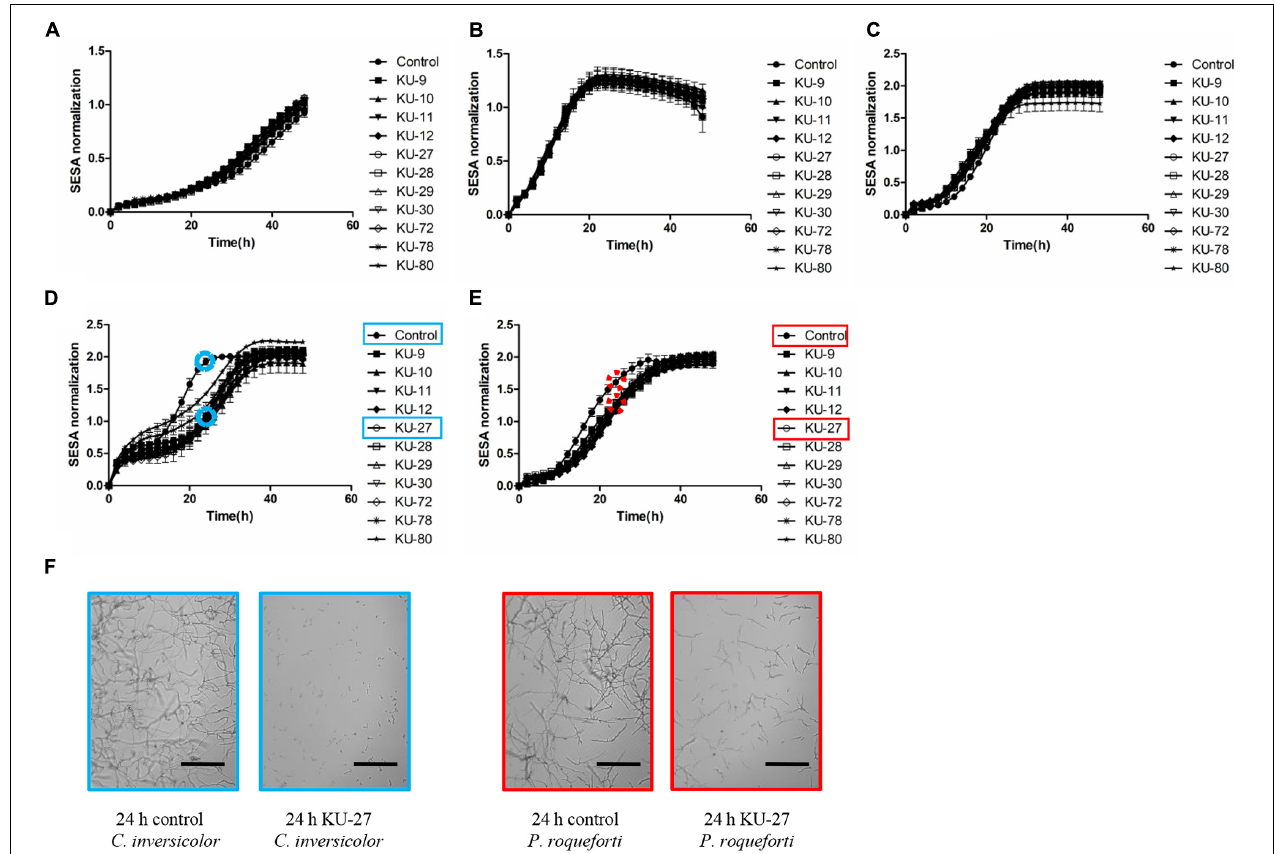
FIGURE 2 | Effects of cell-free supernatants from D. hansenii strains KU-9, KU-10, KU-11, KU-12, KU-27, KU-28, KU-29, KU-30, KU-72, KU-78 and KU-80 on the growth of five mold species measured as Normalized SESA units using oCelloScopeTM. (A) Cladosporium sinuosum , (B) Fusarium avenaceum , (C) Mucor racemosus , (D) Cladosporium inversicolor , (E) Penicillium roqueforti . Each spot represents the mean values from three independent experiments, and the error bars represent the standard deviation. (F) Examples of oCelloScopeTM images of growth measurements of C. inversicolor (blue) and P. roqueforti (red) in yeast peptone media (control) or in the presence of cell-free supernatants of D. hansenii strain KU-27 at 24 h. Scale bar: 300 µ